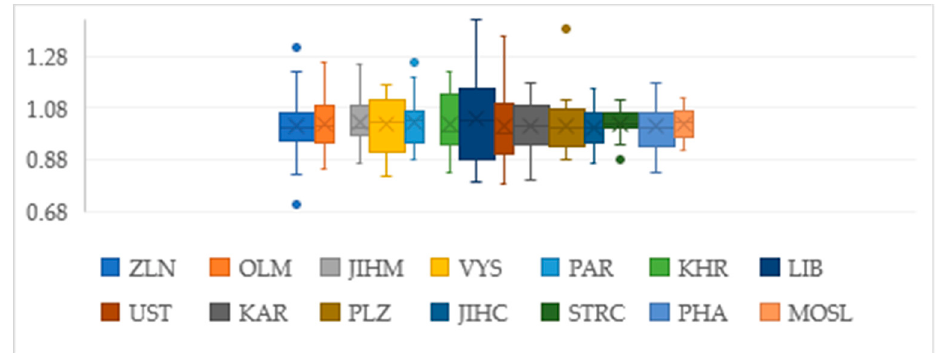
Figure 5. Boxplots of people employed in the Health and Social Care sector in the regions of the Czech Republic and median chain indices for the period 1993–2016.